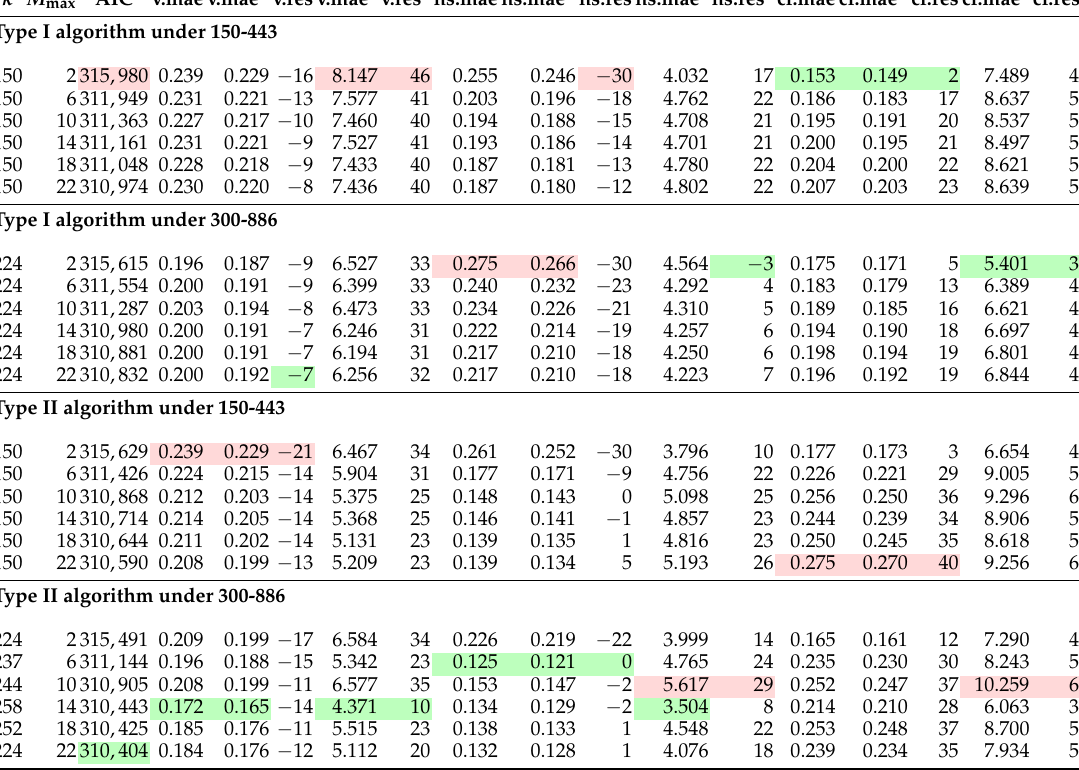
Table A30. AIC scores and out-of-sample validation figures of all derived FGLS proxy functions of BEL under 150–443 and 300–886 after the final iteration. Highlighted in green and red respectively the best and worst AIC scores and validation